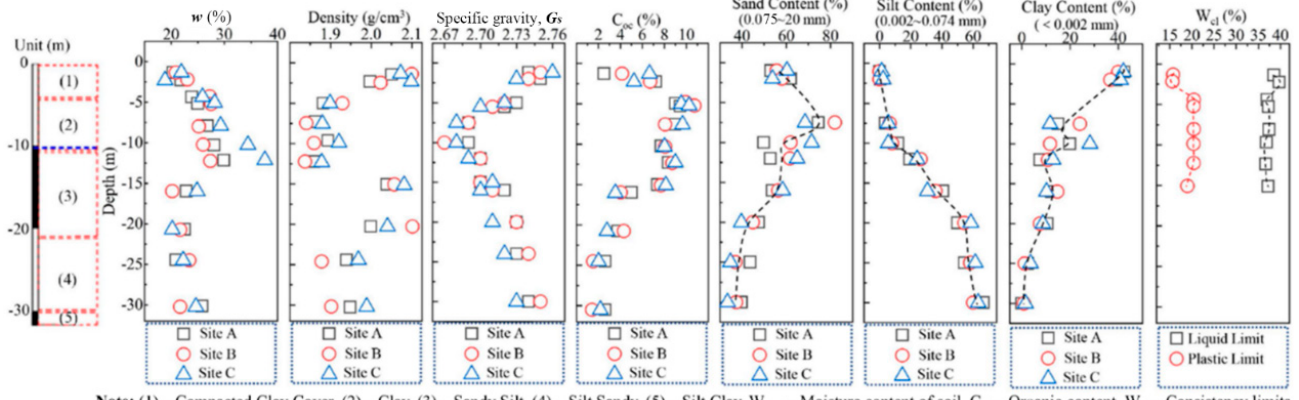
Figure 2. The geological profile and soil properties in the contaminated site.